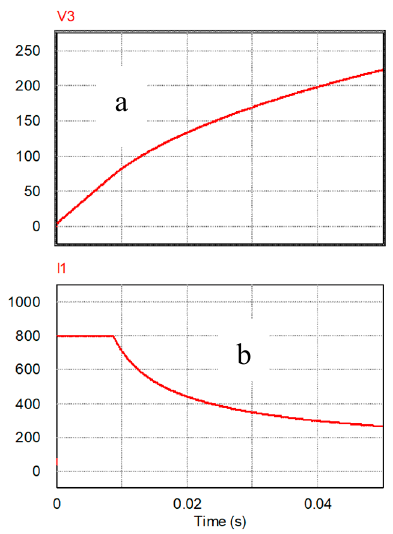
Figure 3. Results of a simulating of a transient process in R-(RC) circuit: ( a ) voltage rise; ( b ) current changing.